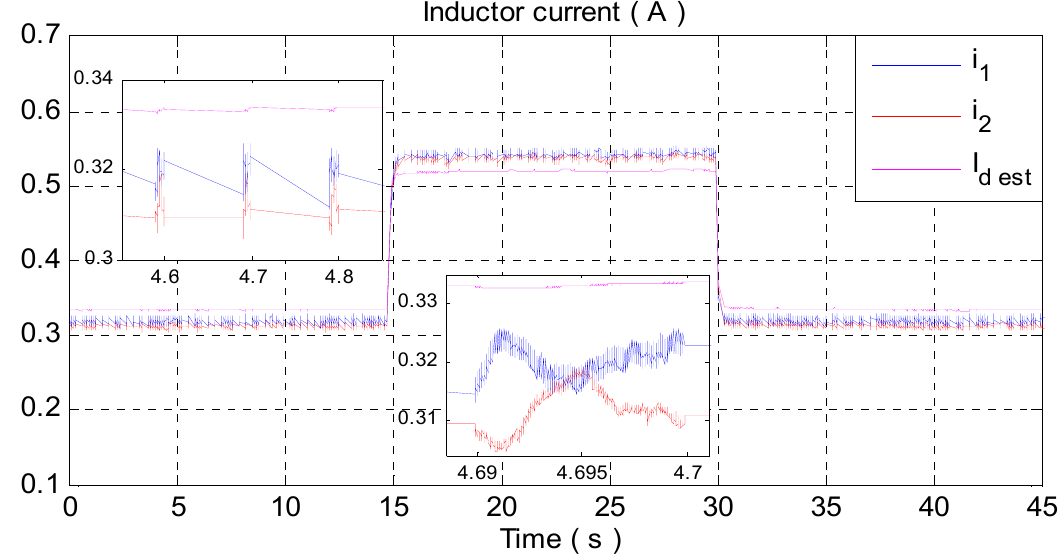
Figure 19. Inductance currents i k of IBBC and its desired value I d est .